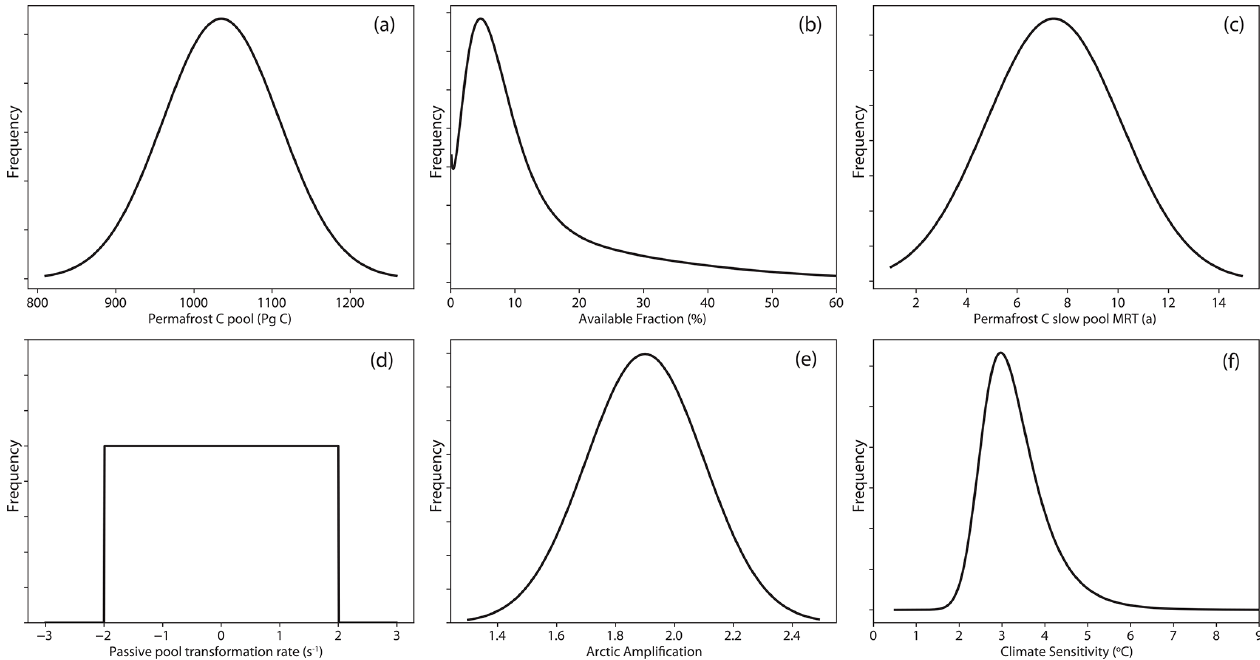
Figure 1. Probability distribution functions of the six parameters perturbed in this study. MRT is mean residence time. Note that (d) has a logarithmic scale. All parameter PDFs except climate sensitivity are that same as in MacDougall and Knutti (2016).